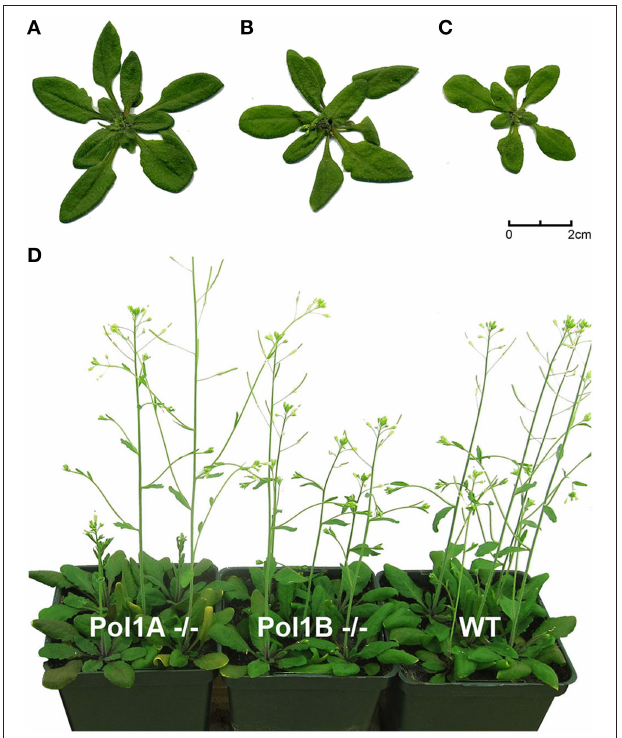
FIGURE 2 | Side by side comparison of 23 dpi WT (A), Pol1A − / − (B) , and Pol1B − / − (C) plants. Note the slightly delayed growth of Pol1B − / − plants and the lack of a distinguishable phenotype between WT and Pol1A − / − plants (D) .